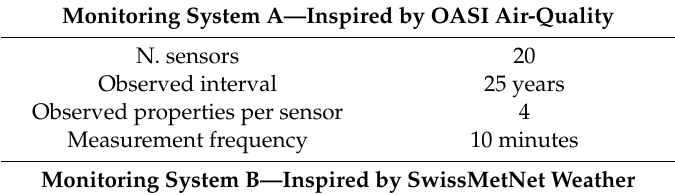
Table 2. Configuration of the tested monitoring systems inspired by real case applications.